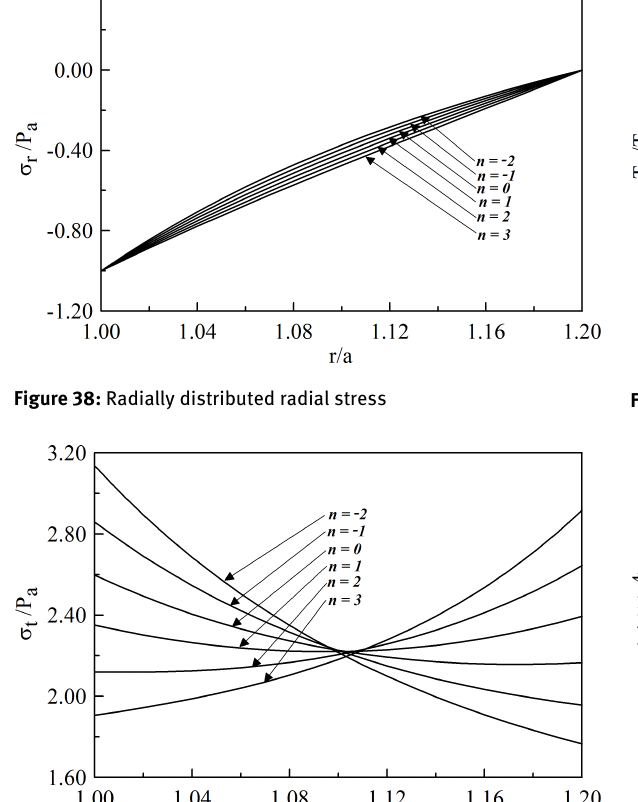
prox.) the von-Mises stress is directly proportional to the grading parameter. The values are given in Table 1 for b/a = 1.08 for corresponding to grading parameters, and differ- ent loading